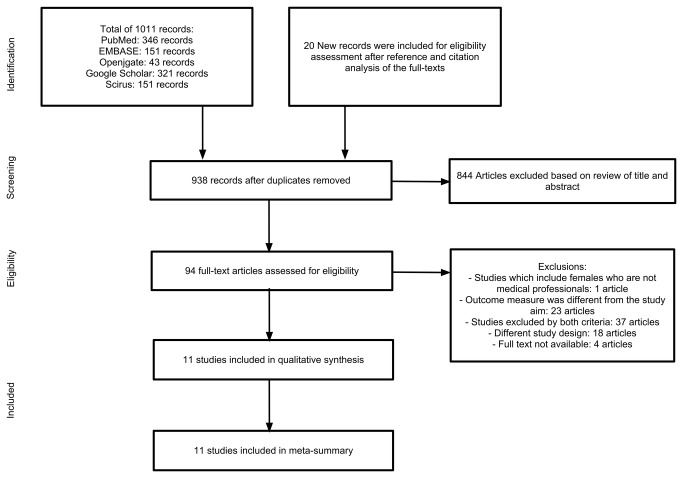
PRISMA flowchart.